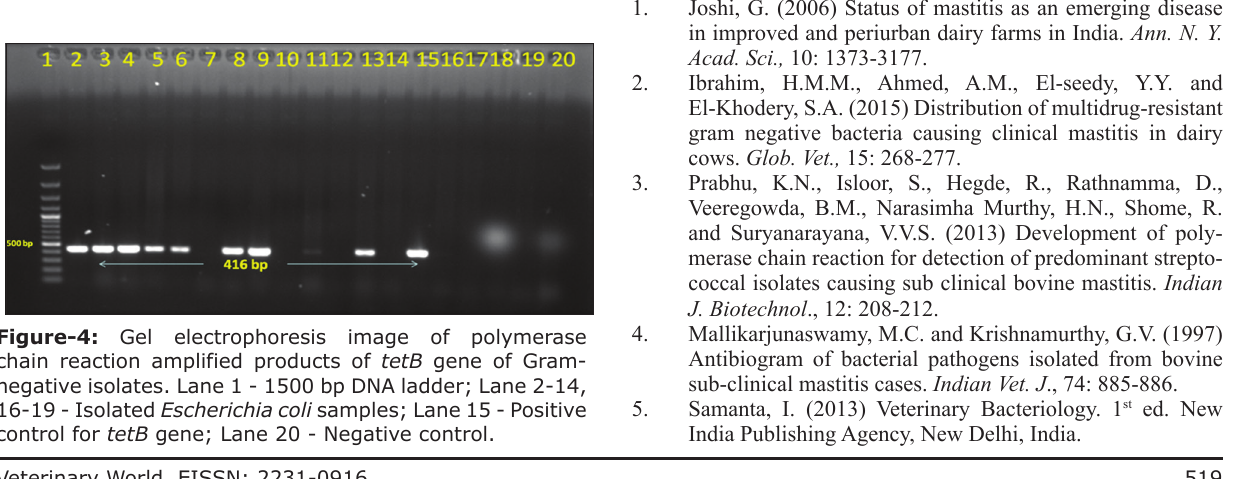
Figure-3: Gel electrophoresis image of polymerase chain reaction amplified products of tetA gene of Gram- negative isolates; Lane 1 - 1500 bp DNA ladder; Lane 2-16, 18-19 - Isolated Escherichia coli samples; Lane 17 - Positive control for tetA gene; Lane 20 - Negative control.